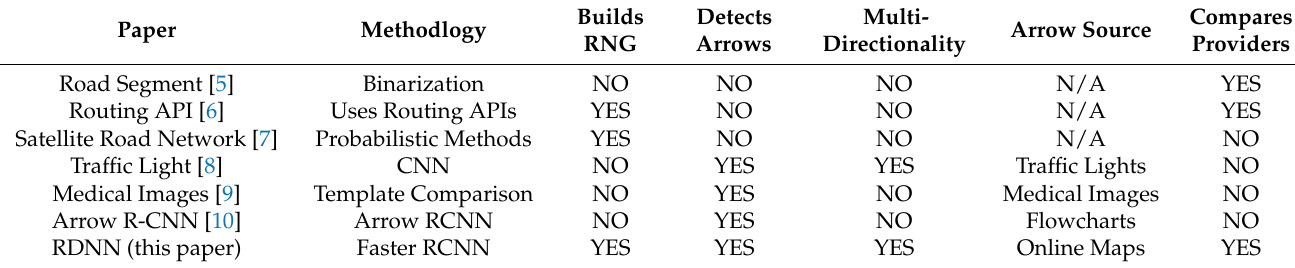
Table 1. Comparison of related